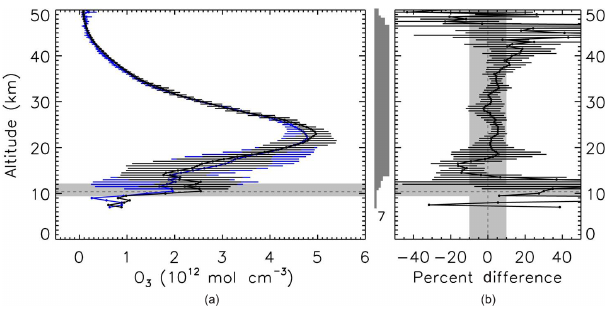
Figure 3. Similar to Fig. 2 but for the average difference of coin- cident pairs of ozone profiles for SAGE III-ISS and Lauder ozone lidar data from June 2017 to May